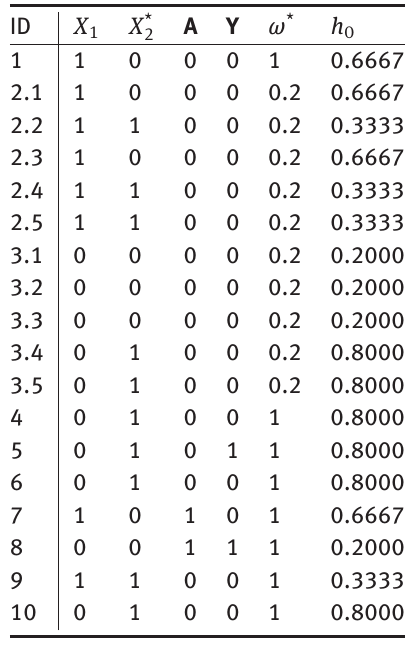
Table A3: Initial imputed data set prior to the first